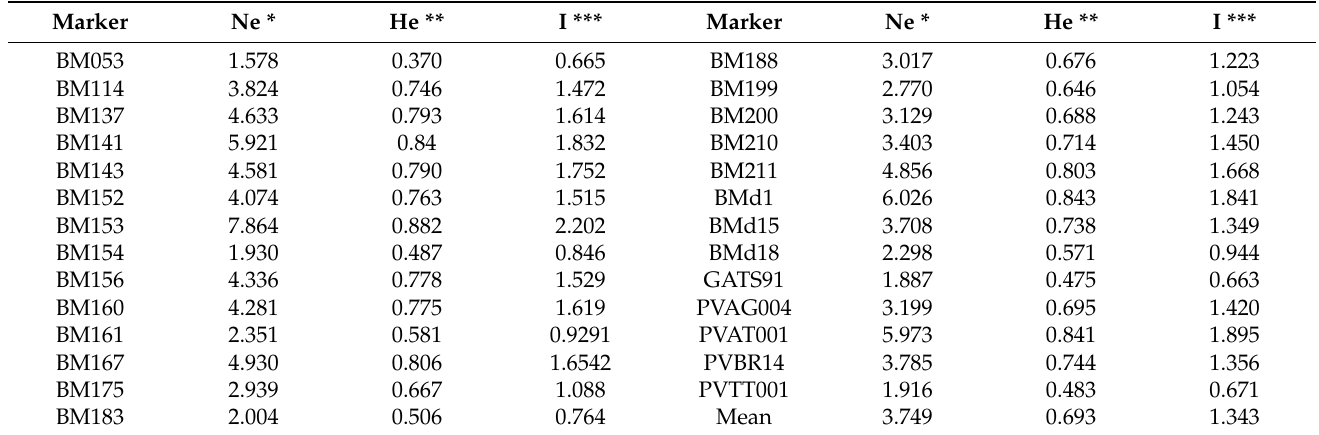
Table 4. Effective number of alleles (Ne), expected heterozygosity (He) and Shannon information index (I) based on 27 SSR loci bean